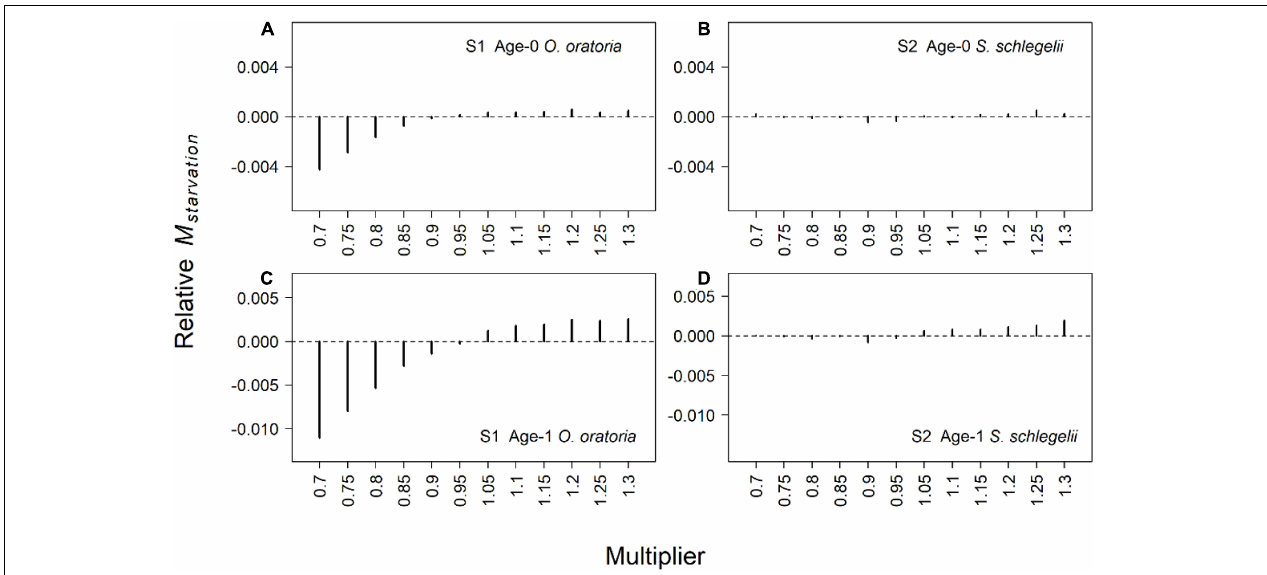
FIGURE 5 | Relative changes of starvation mortality rate for two age groups of target species under different fishing scenarios. The relative changes were the difference between scenarios S1–2 and the reference state. Scenarios S1 and S2 considered O. oratoria and S. schlegelii as target species, respectively. The fishing mortality multipliers of each non-target species were set from 0.7 (Fx0.7) to 1.3 (Fx1.3) with a step equal to 0.05. (A) Relative starvation mortality of age-0 O. oratoria in S1, (B) relative starvation mortality of age-0 S. schlegelii in S2, (C) relative starvation mortality of age-1 O. oratoria in S1, and (D) relative starvation mortality of age-1 S. schlegelii in S2.